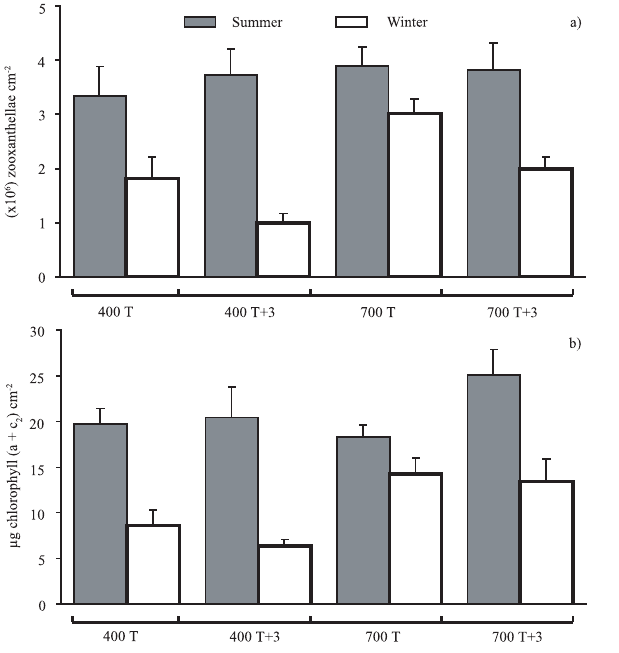
Fig. 3. Zooxanthellae density (a) and chlorophyll content (b) mea- sured after one-month acclimation during the mid-term experiments (summer and winter) on Cladocora caespitosa exposed to the com- bined effect of normal (400µatm) and elevated (700µatm) p CO 2 , and normal ( T ) and elevated ( T +3 ◦ C) temperatures. Data are mean ± s.e.m. (see Table 2 for degrees of freedom).